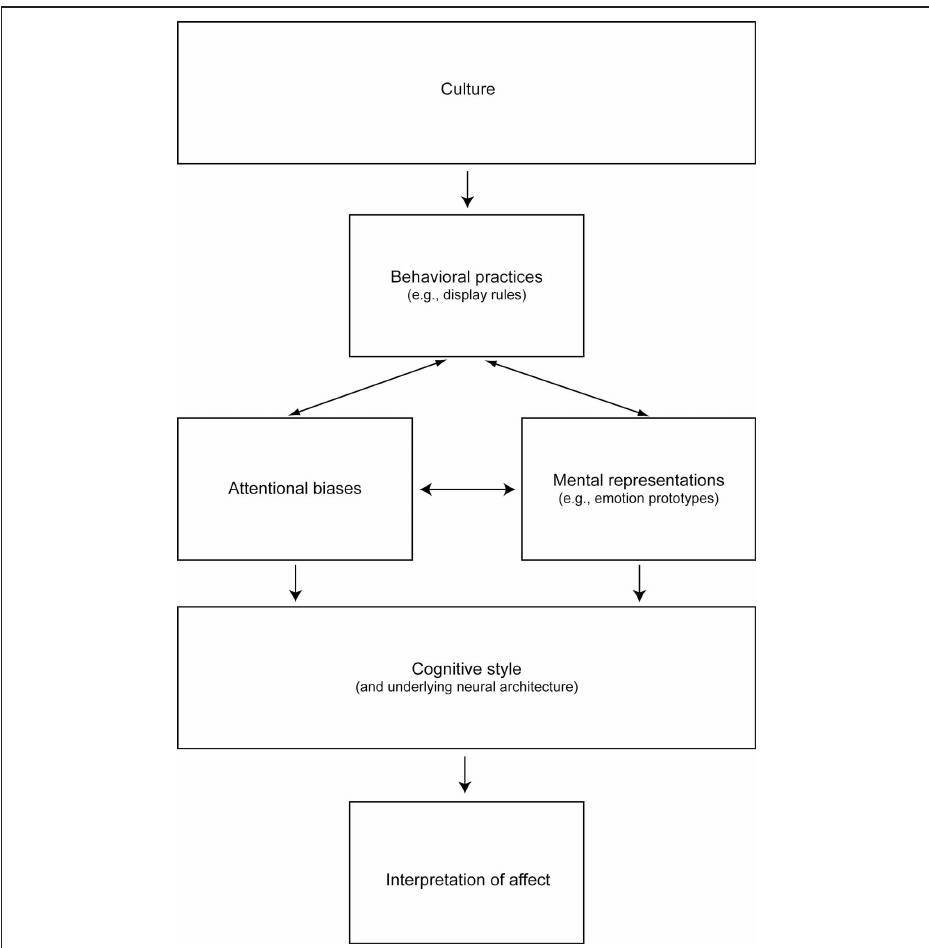
FIGURE 2 | Cascade of cultural influences on interpretations of emotional expressions. Culture shapes display rules and behavioral practices, which, through learning, influence specific cognitive mechanisms, such as attentional biases and mental representations. Specifically, sustained exposure to cultural practices influences the way individuals process information from the environment. For example, display rules may lead to culture-specific enhancements and reductions in exposure frequency and intensity of specific emotion displays. Display rules thereby mediate perceptual learning about facial expressions, which in turn shapes attentional biases and mental representations. Sustained exposure to such behavioral practices leads to the formation of cognitive styles, which shape how emotional expressions are interpreted across cultures. Culture-specific cognitive styles are mediated